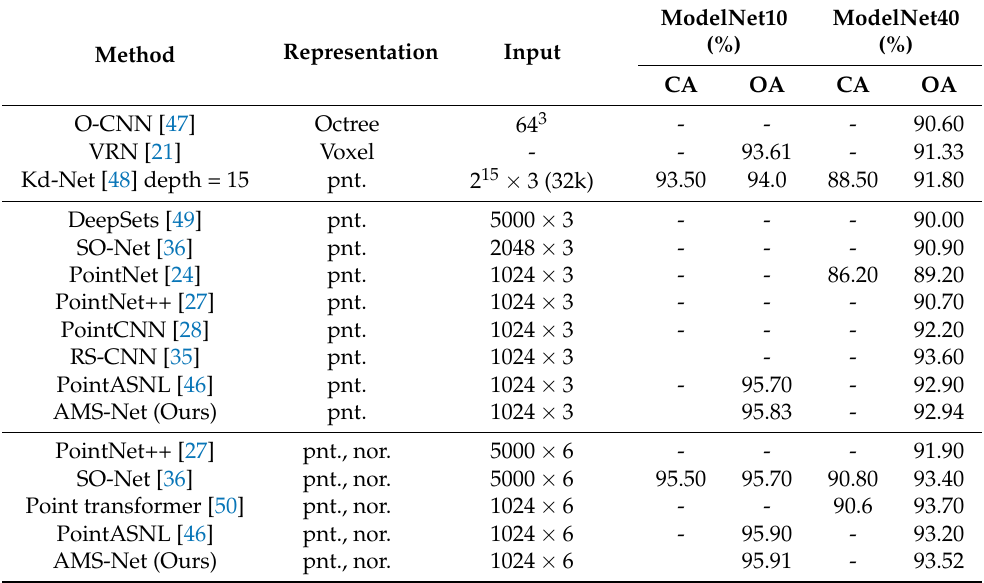
Table 2. Classification results on ModelNet40/10. (“CA” stands for per-class accuracy; “OA” stands for overall accuracy; “pnt” stands for xyz-coordinates of point and “nor” stands for surface normal vector; “-” stands for unknown.).